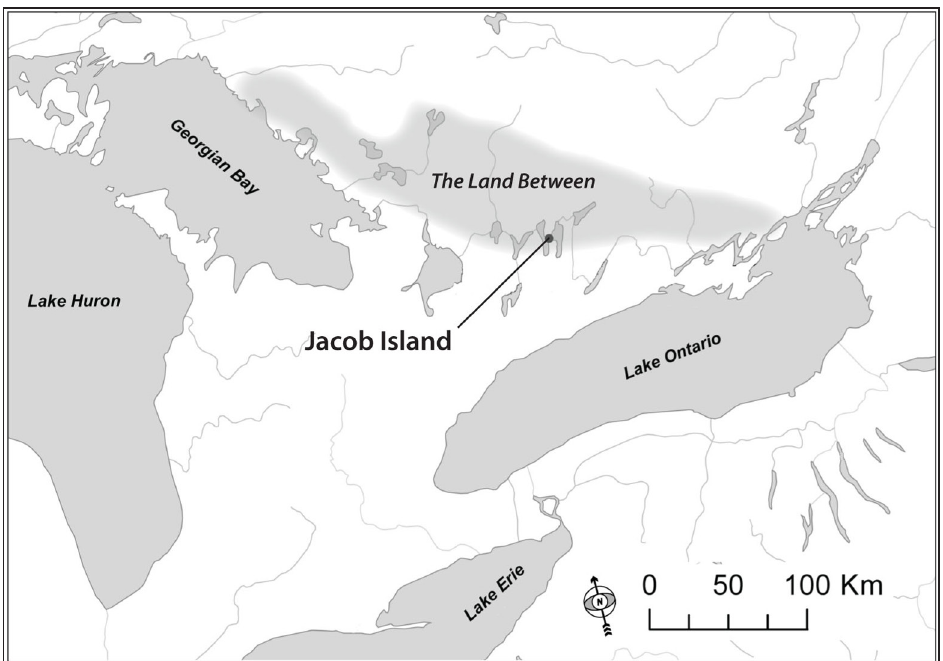
Figure 1: Location of Jacob Island in the Lower Great Lakes (Photo